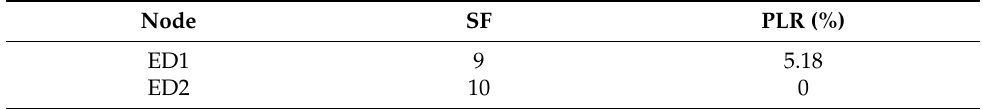
Table 4. Analysis of PLR between SF9 and SF10.